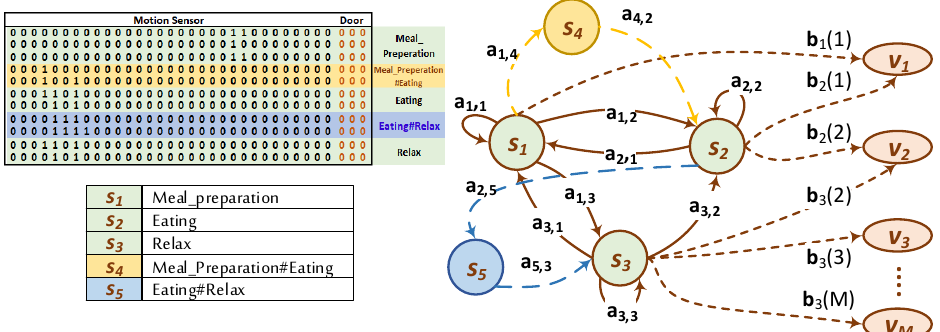
Figure 4. Paradigm #3: A new state is created for each annotation gap and stamped by its ordered encapsulating activities in